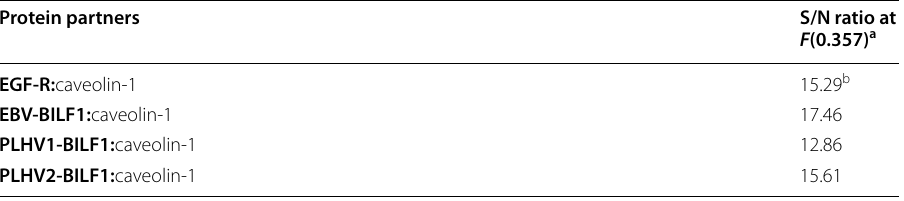
a A lower S/N ratio indicates lower interaction affinity b Interaction of caveolin-1 and epidermal growth factor receptor (EGF-R) was used as a positive control [58]